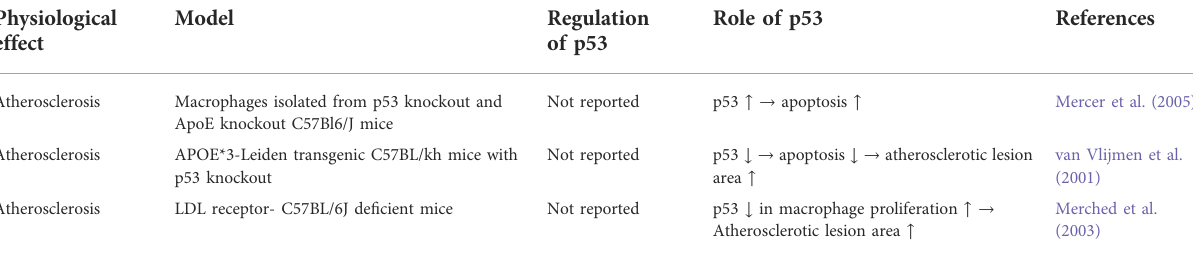
TABLE 3 Summary of regulation of p53 in macrophage during